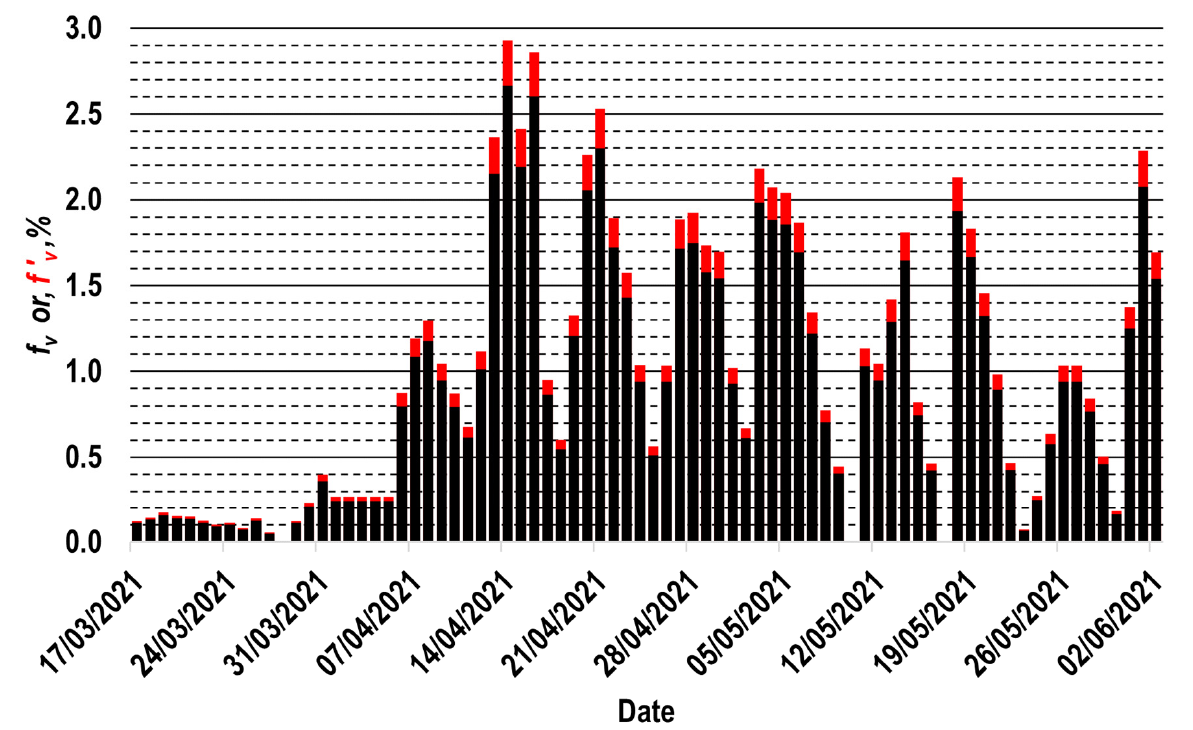
Figure 2. Vaccination profiles, referred to the completion date of the respective vaccination schemes. Profile considering officially published real-time information ( 𝑓 (cid:3049) ; black [44]), or assuming an under- estimation of 10% in this profile ( 𝑓′ (cid:3049) ; red [44,46]).